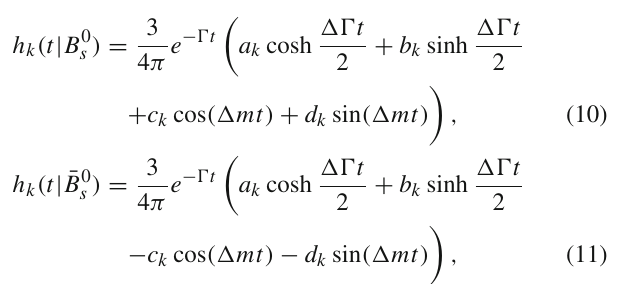
Fig. 10 a Distribution of the decay time for B 0 s → D − s π + candi- dates tagged as mixed and unmixed with the projection of the fit result, which is described in the text. b Calibration of the SSK tagger using B 0 s → D − s π + decays. The black points show the average measured mistag probability, ω , in bins of predicted mistag, η , the red line shows